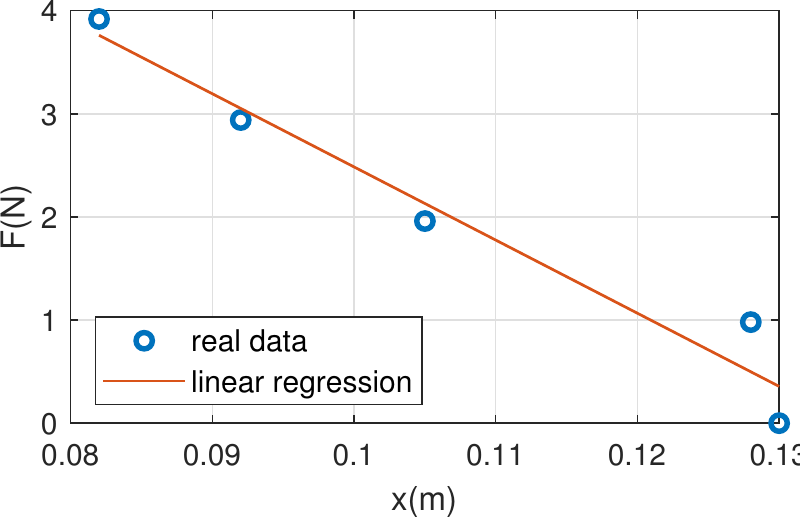
Figure 10. Linear regression to obtain the spring elastic constant K from experimental